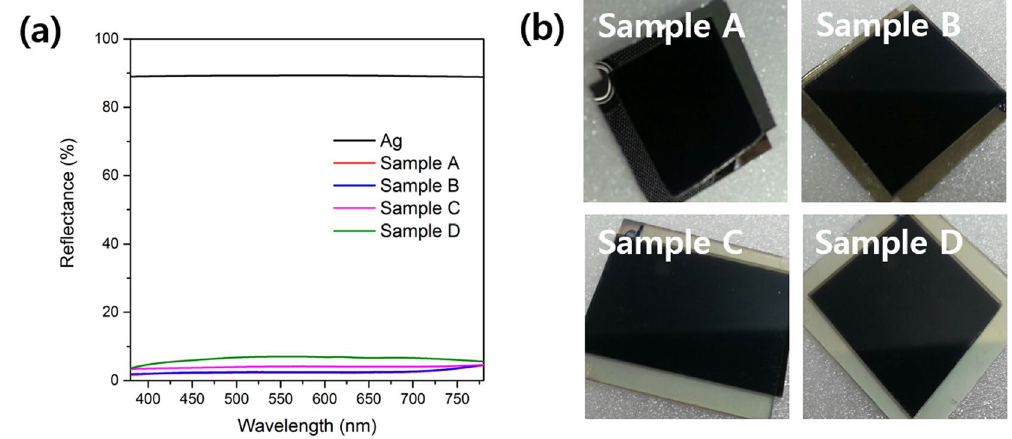
Figure 7. ( a ) The reflectance of various samples and ( b ) black color of various